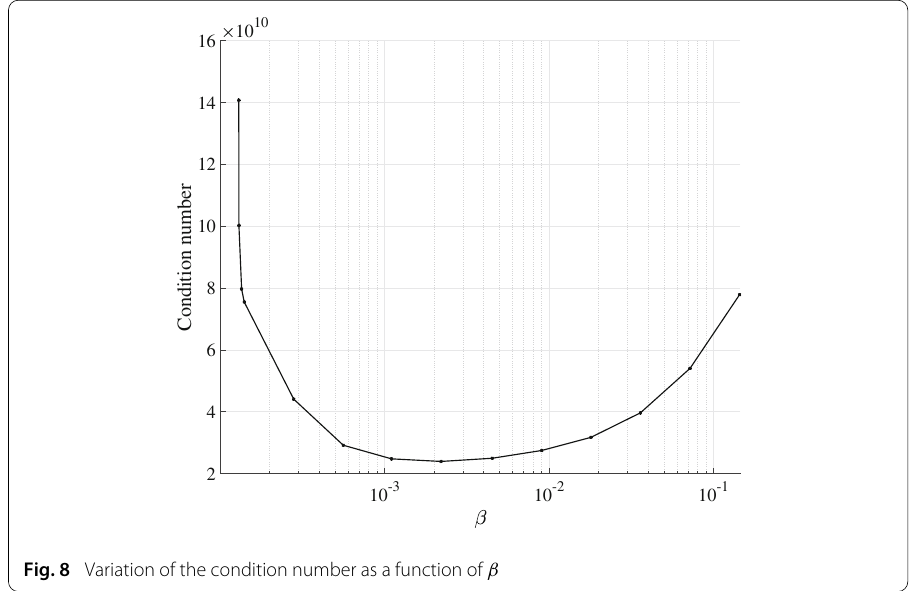
Fig. 8 Variation of the condition number as a function of β